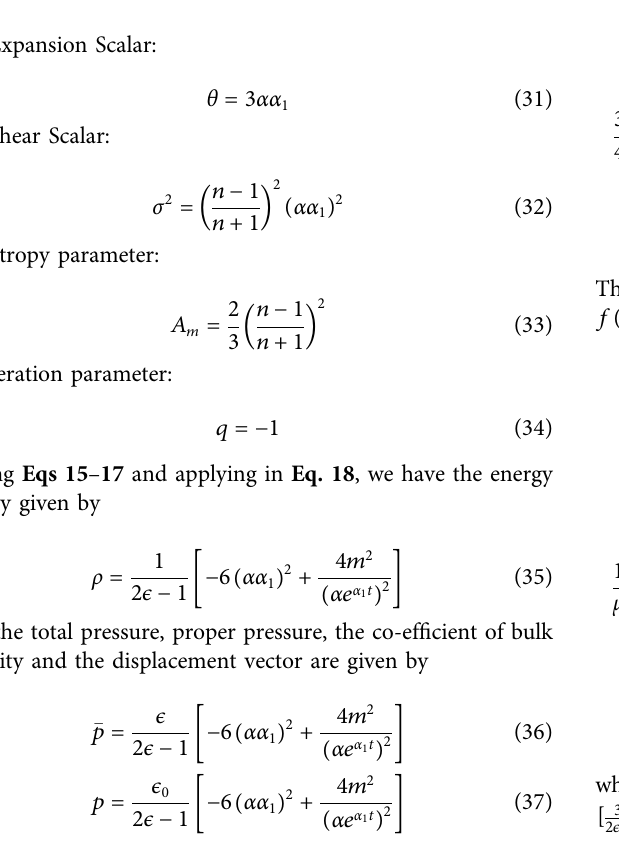
FIGURE 5 | Variation of strong energy condition vs . time ( t